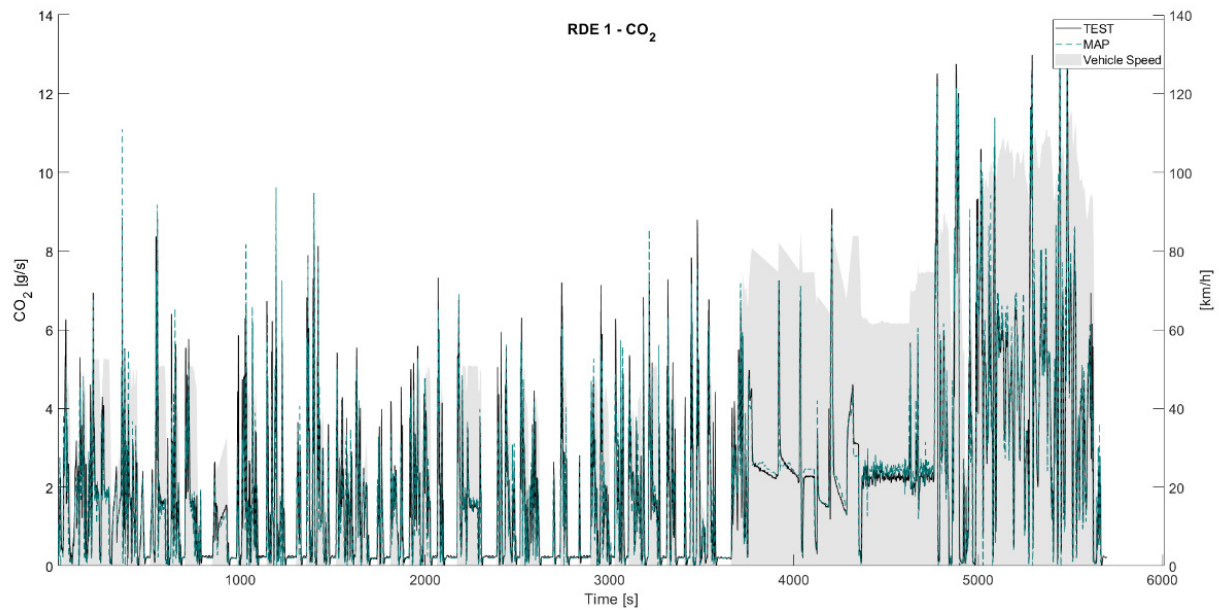
Figure 11. RDE 1 CO 2 [g/s] emissions test versus engine map.